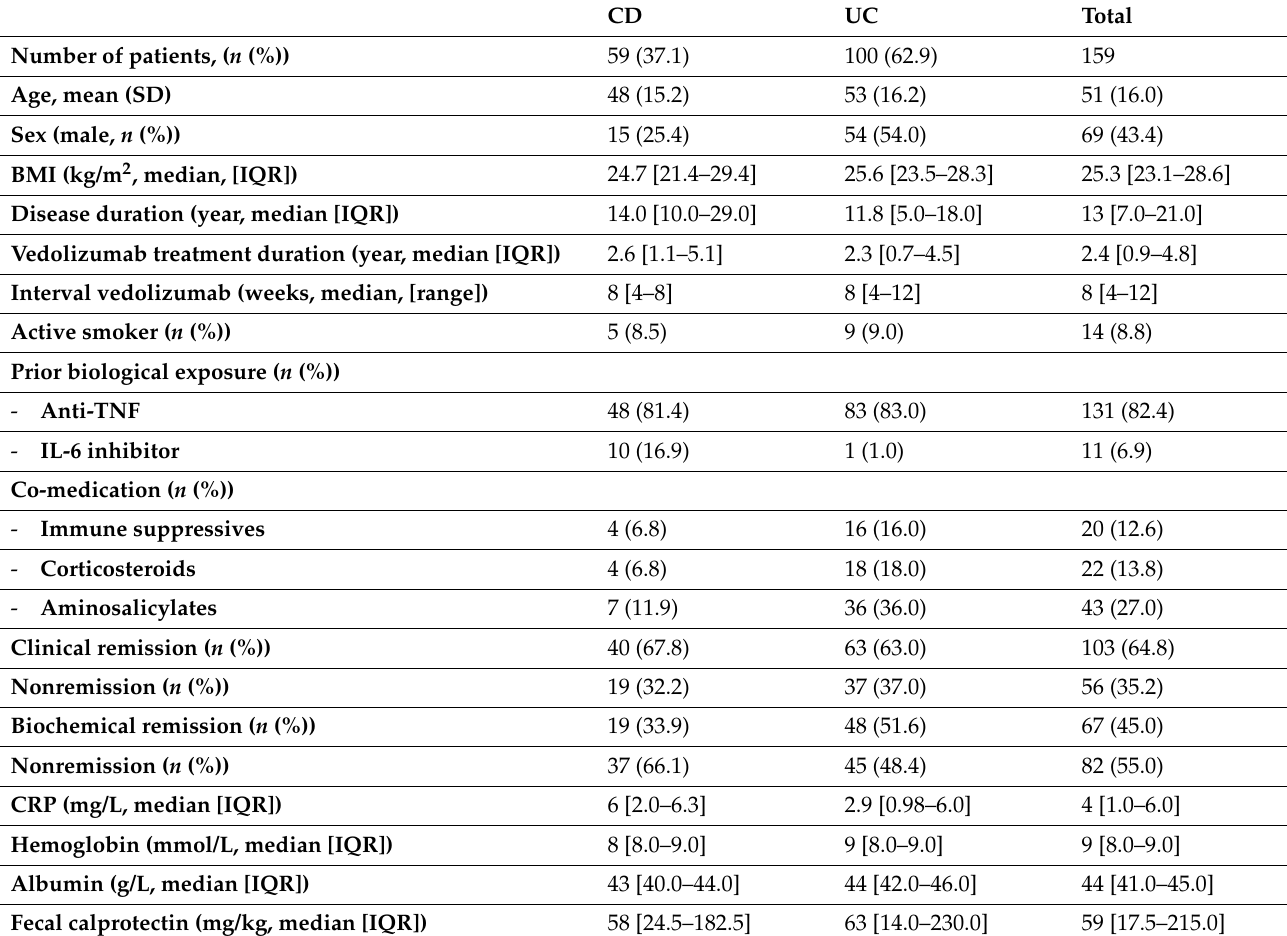
Table 1. Baseline patient